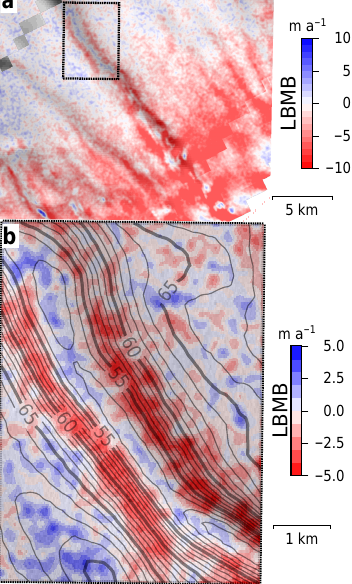
Figure 6. (a) Lagrangian basal mass balance around an ice shelf channel near the grounding line. The box is located in Fig. 4. (b) Close-up view of the box delineated in panel (a) , with 1m ele- vation contour lines. Enhanced melting is observed at the channel’s